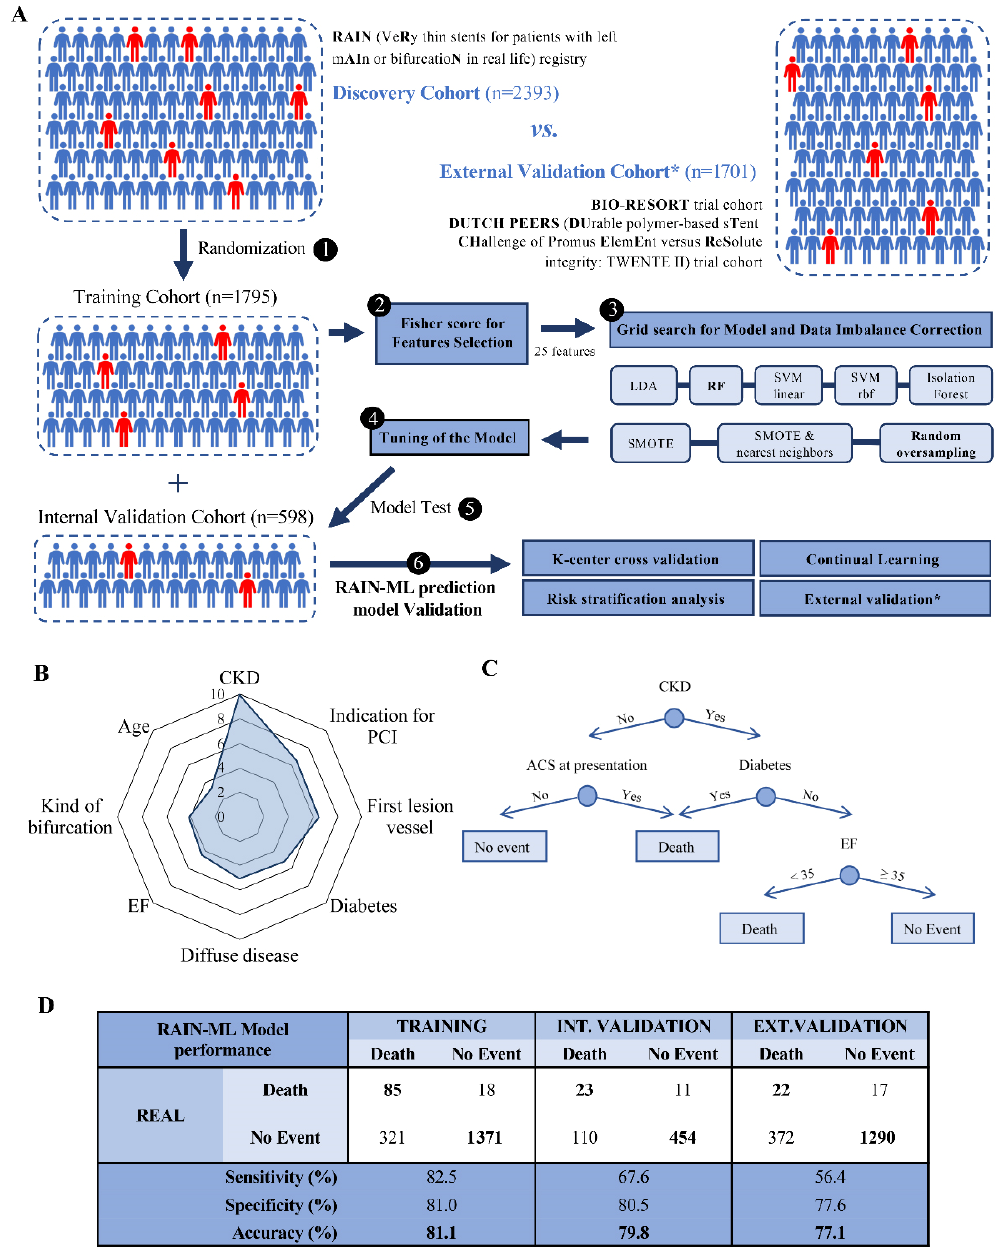
Figure 1. RAIN-ML model. The RAIN-ML prediction model was built in the discovery cohort (n = 2393). ( A ) The discovery cohort was randomized in a training and in an internal validation cohort. The model was developed in the training cohort (n = 1795): 5 machine learning models (linear discriminant analysis [LDA], random forest regressor [RF], support vector machine [SVM] with differ- ent kernels, and isolation forest) and 3 algorithms for dataset imbalance correction (SMOTE, Synthetic Minority Oversampling Technique, SMOTE & nearest neighbours, and random oversampling) have been evaluated; the best model was an RF with random oversampling algorithm (reported in bold). The model was then tested in the internal and external validation cohorts (n = 598, n = 1701, respectively) and by K-center cross-validation, risk stratification analysis, and continual learning. ( B ) Radar chart reporting the 8 normalized best predictors associated with patient out- come. ( C ) Representative classification tree from the RAIN-ML RF model. ( D ) Confusion matrix, real and predicted diagnosis (Death vs. No event), accuracy, sensitivity, and specificity for the RAIN-ML model at training, internal validation, and external validation. CKD, Chronic Kidney Dis- ease; PCI, Percutaneous Coronary Intervention; EF, Ejection Fraction; ACS, Acute Coronary Syn- drome.